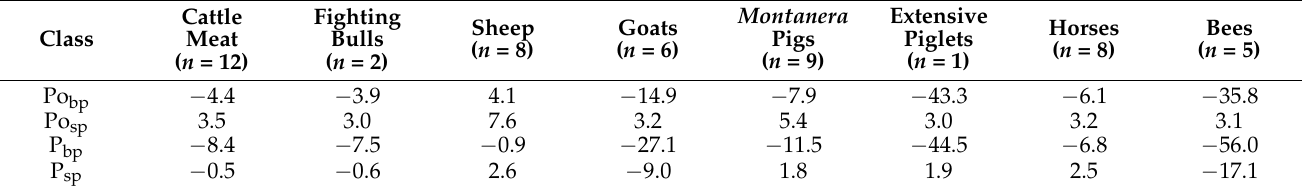
Table 7. Livestock species profitability rates under the AAS for large privately owned case-study dehesas in Andalusia (2010: %).